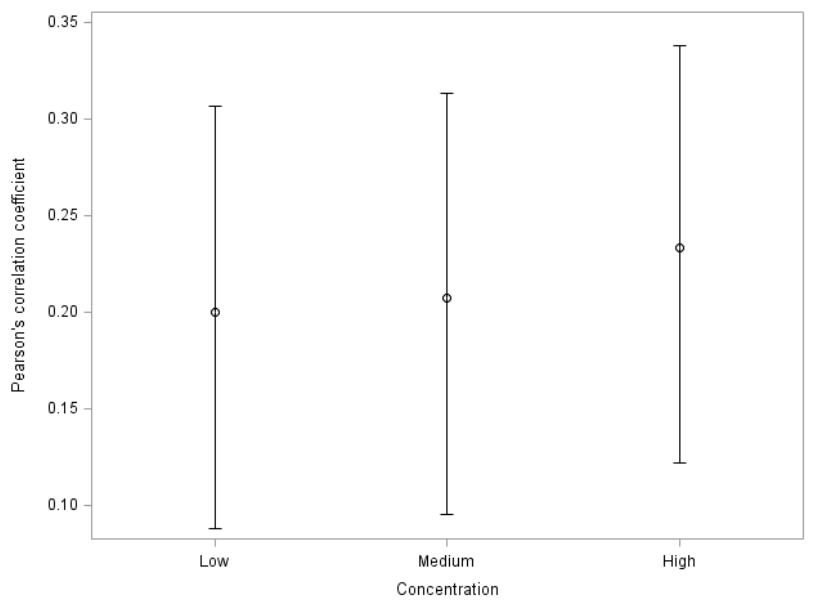
Figure 1. Values of Pearson’s product-moment correlation coefficient ( r ). Whiskers represent intervals at 95% confidence for low, medium, and high lactate concentration groups.